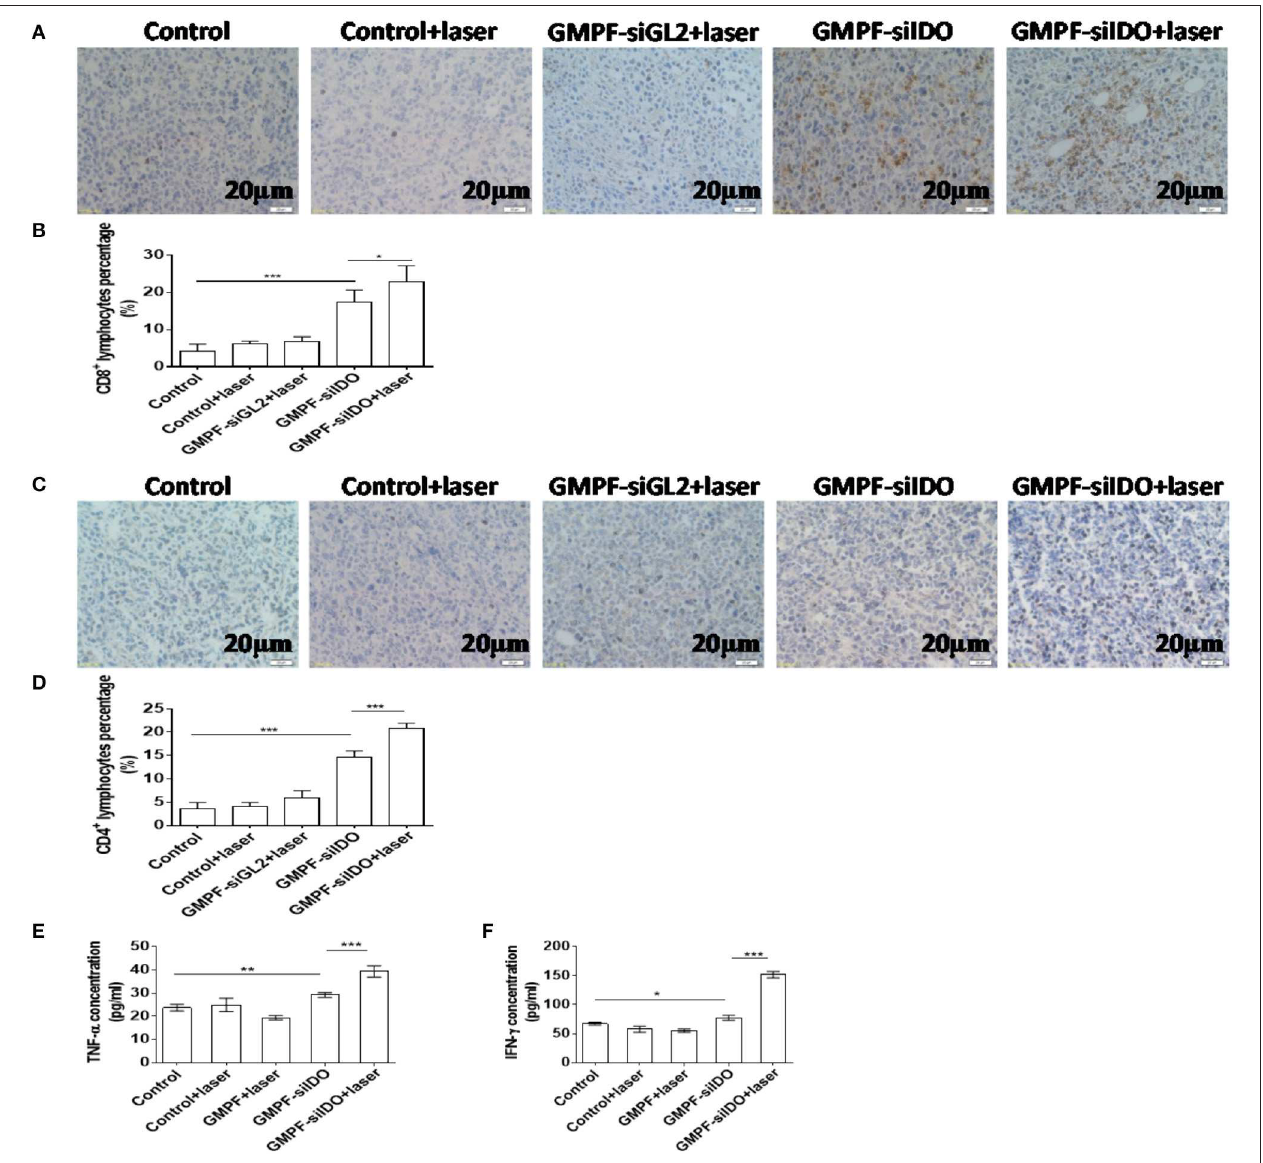
FIGURE 7 | Increased tumor-infiltrating T cells and up-regulated inflammatory cytokines after photothermal-immunotherapy. (A–D) Increased TILs in tumor tissue. Lung cancer-bearing mice were treated with PBS (control), GMPF-siGL2 or GMPF-siIDO, with or without laser irradiation. Tumor tissues were collected and subjected to immunohistochemistry assays and CD8 + (A,B) and CD4 + (C,D) lymphocytes in tumor tissue were counted. (E,F) Upregulated inflammatory cytokines. At the endpoint of experiment, the mice were sacrificed, and total blood was also collected. The TNF- α (B) and IFN- γ (C) in blood were analyzed by ELISA assay. Error bars represent the standard deviation of three experiments (* P < 0.05; ** P < 0.01; *** P <